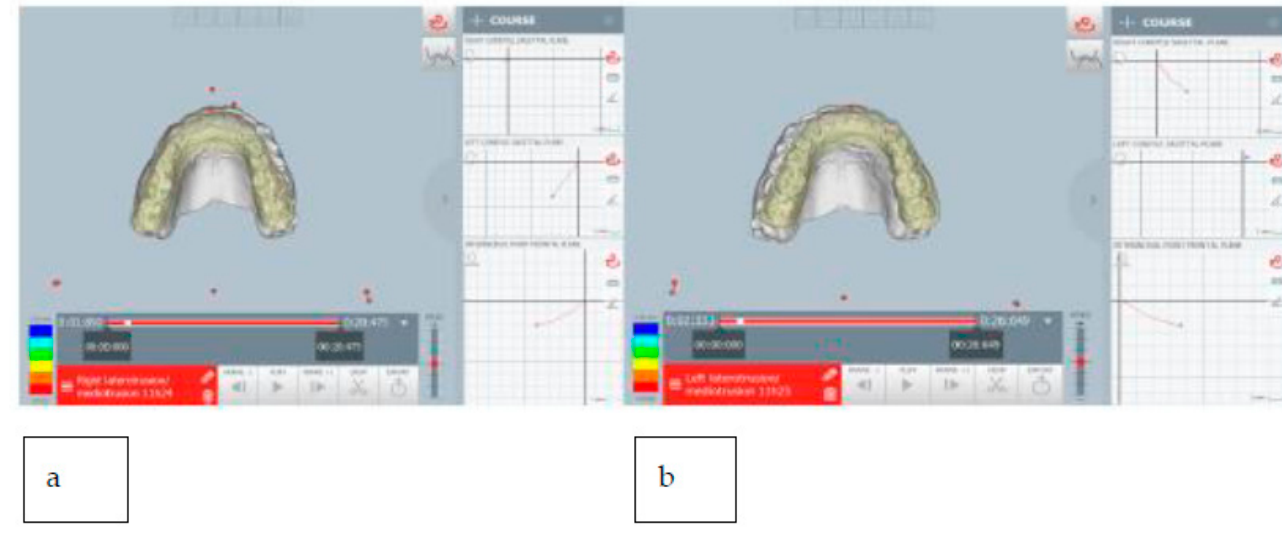
Figure 19. Lateral tracings, right ( a ) and left ( b ) sides.